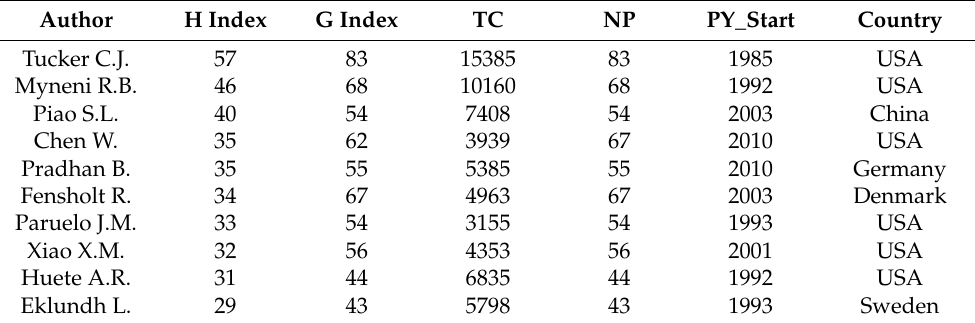
Table 5. Top ten most influential authors ranked by the H